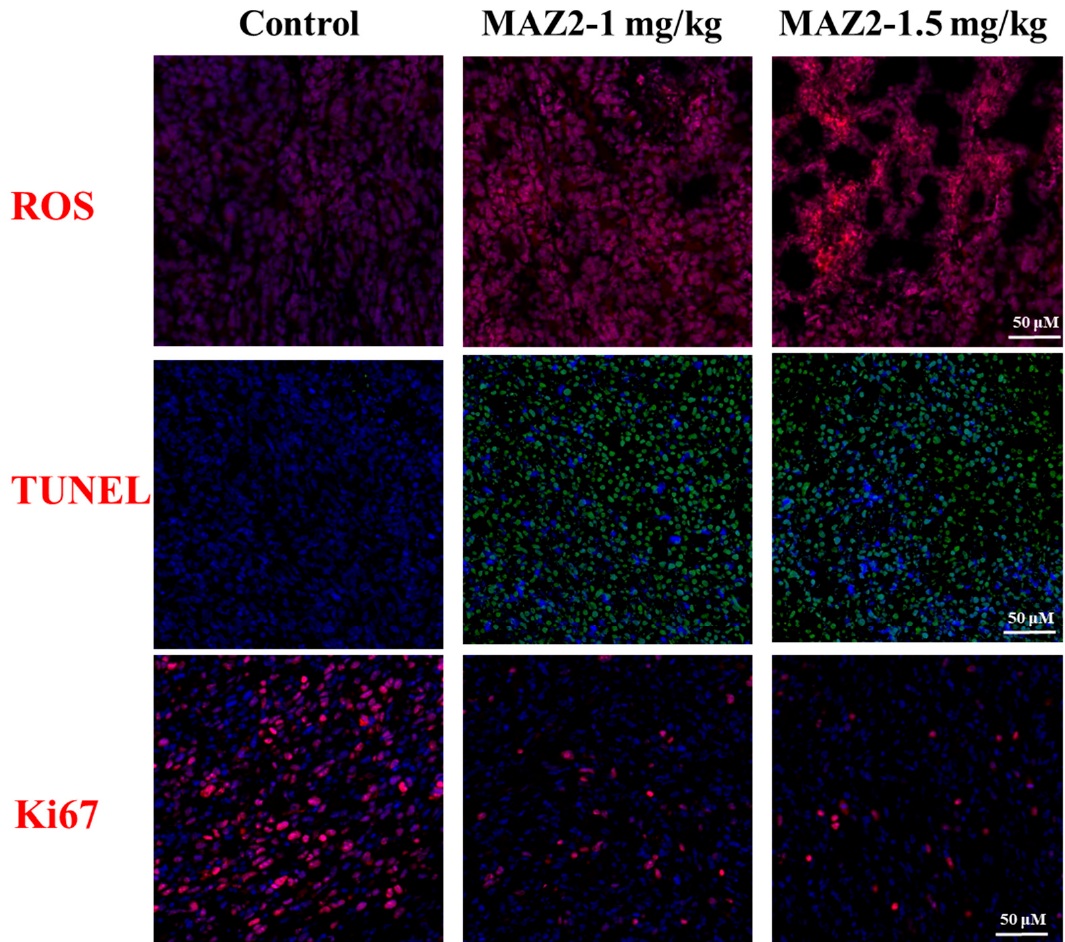
Figure 5. Staining of tumor tissues. ROS: blue-nuclear, red-ROS; TUNEL: blue-nuclear, green-TUNEL; Ki67: blue-nuclear, red-Ki67.